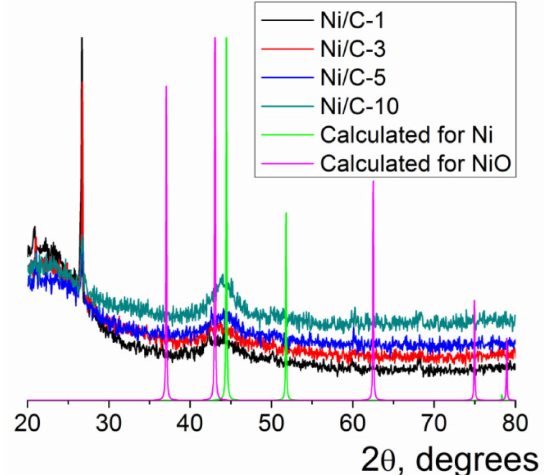
Figure 2. Powder XRD patterns of the Ni/C-X composites along with the calculated XRD pattern for Ni (Fm3m) and NiO (Fm3m). The intensity of the calculated reflections was arbitrarily adjusted just for illustrative purposes.